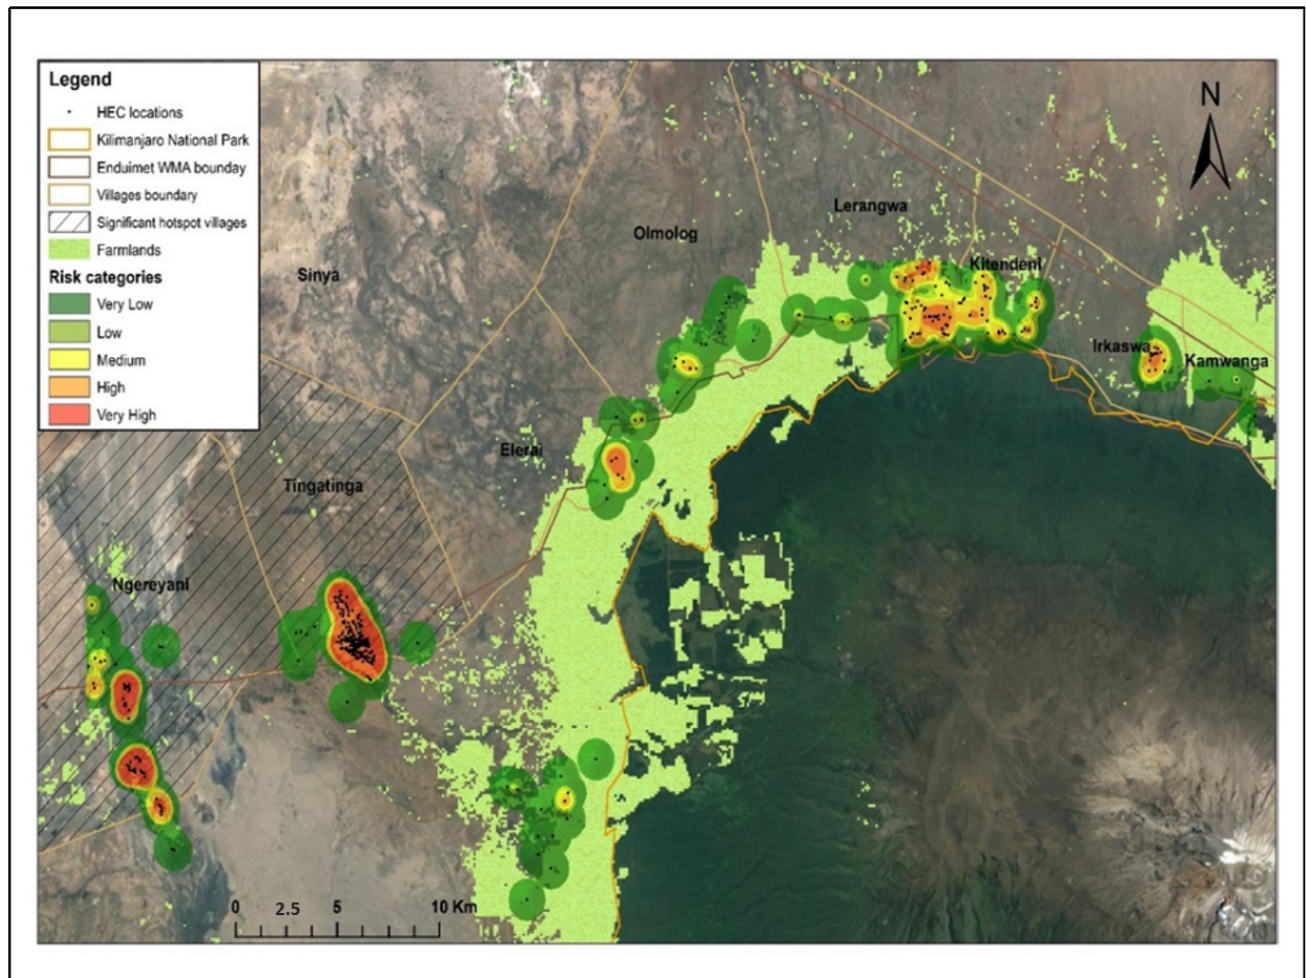
Figure 3. Heat map of areas with a high risk of being a crop foraging hotspot for elephants in the Enduimet Wildlife Management Area and close farmlands adjacent to the southern part of EWMA, Tanzania ( n = 923), generated from HEC data collected by OIKOS East Africa and interviews ( n = 96) between the years 2016 to 2020.